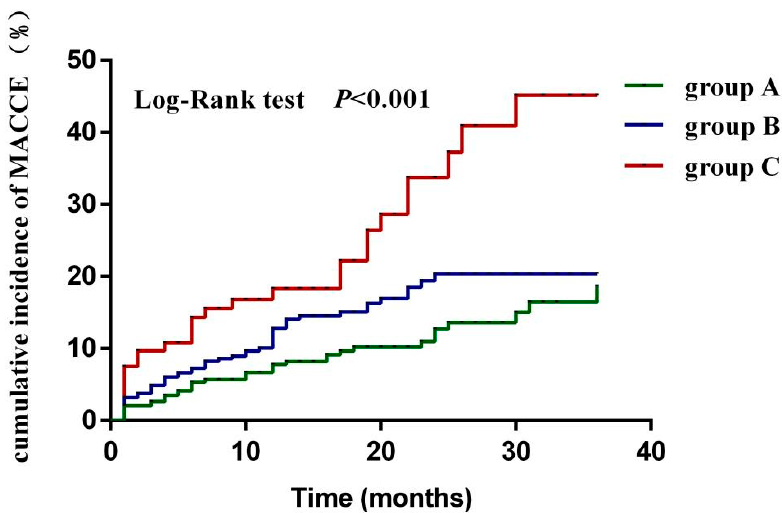
Figure 4. Comparison of the cumulative MACCE incidence between groups of Lp(a) combined with fibrinogen.